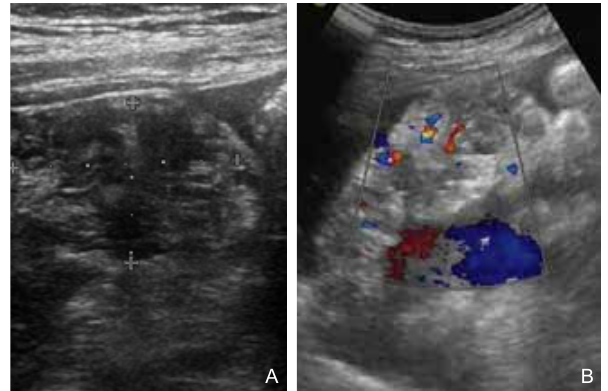
Figure 1 US examination. (A) High frequency linear array probe imaging showed thickened omentum with mixed echogenic appearance; (B)